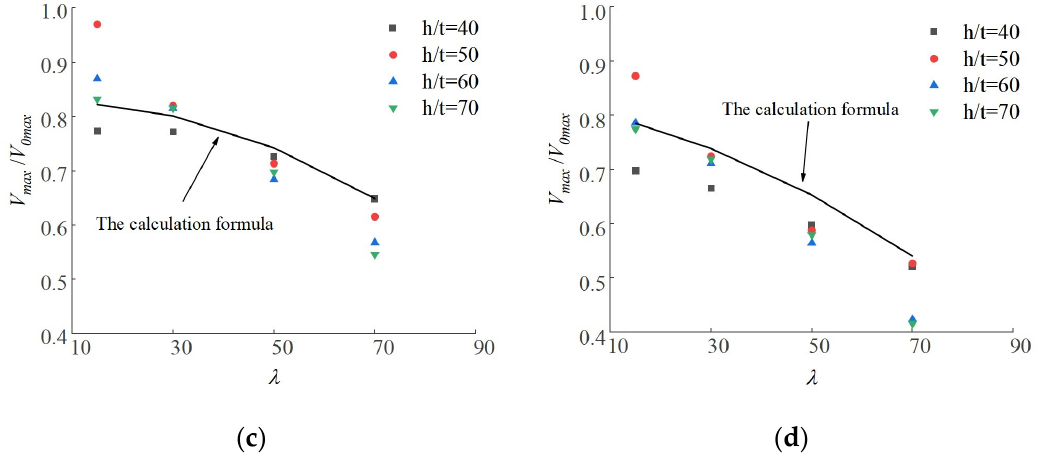
Figure 18. The effect of λ on V max / V 0 max . ( a ) n = 0.1; ( b ) n = 0.2; ( c ) n = 0.3; ( d ) n = 0.4.